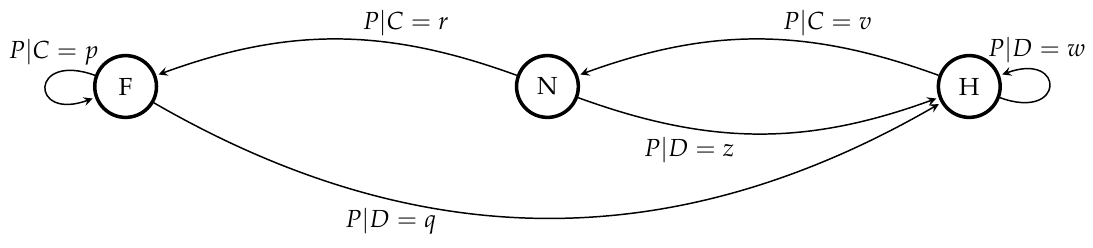
Figure A1. State transitions. The emotional players can transition between three states of mind and the transitions depend stochastically on the observed actions of the other